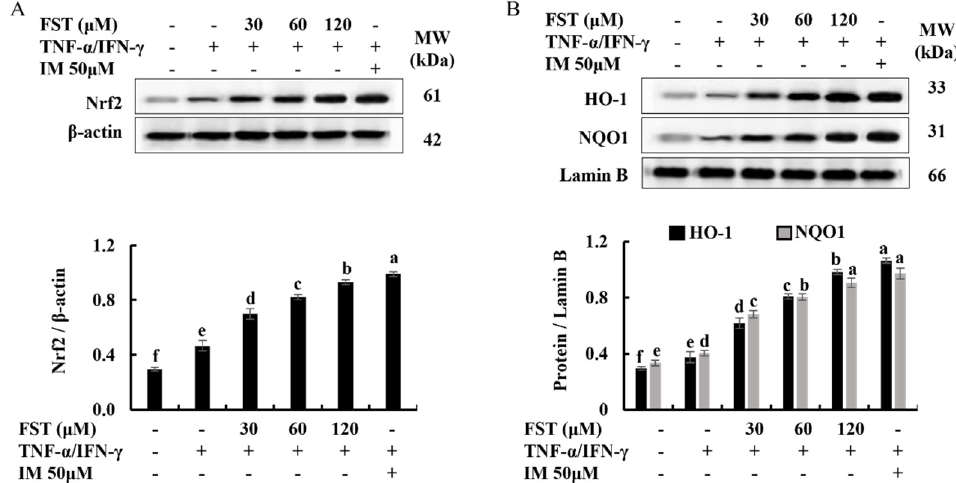
Figure 3. Dose-dependent effect of FST on Nrf2-mediated activation of HO-1 and NQO1 in TNF- α /IFN- γ -stimulated HDF cells. ( A ) Nrf2 expression, and ( B ) HO-1 and NQO1 expression. All experiments were performed in triplicate ( n = 3) to determine the repeatability and lettered error bars were significantly different within the same molecule ( p < 0.05).